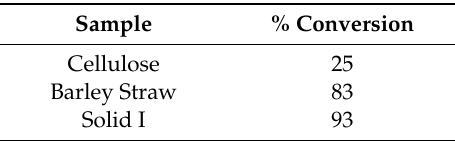
Table 3. Results of conversion obtained after hydrolysis of untreated cellulose, untreated barley straw and barley straw treated (Solid I) with [EMIMAcO]. Reaction conditions: H 2 SO 4 (0.2 mol/L), 140 °C and 5 h.